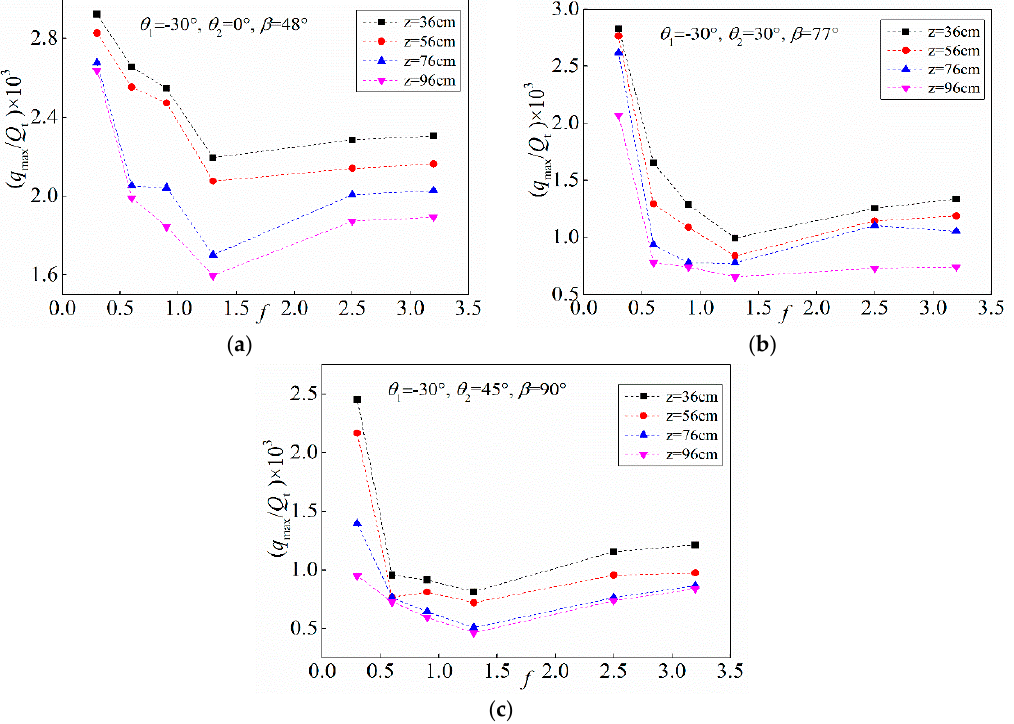
Figure 7. The maximum rainfall varies with the collision angles and flow ratios at different sections. ( a ) θ 1 = − 30°, θ 2 = 0°, and β = 48°; ( b ) θ 1 = − 30°, θ 2 = 30°, and β = 77°; ( c ) θ 1 = − 30°, θ 2 = 45°, and β = 90°. ( a ) θ 1 = − 30 ◦ , θ 2 = 0 ◦ , and β = 48 ◦ ; ( b ) θ 1 = − 30 ◦ , θ 2 = 30 ◦ , and β = 77 ◦ ; ( c ) θ 1 = − 30 ◦ , θ 2 = 45 ◦ , and β = 90 ◦